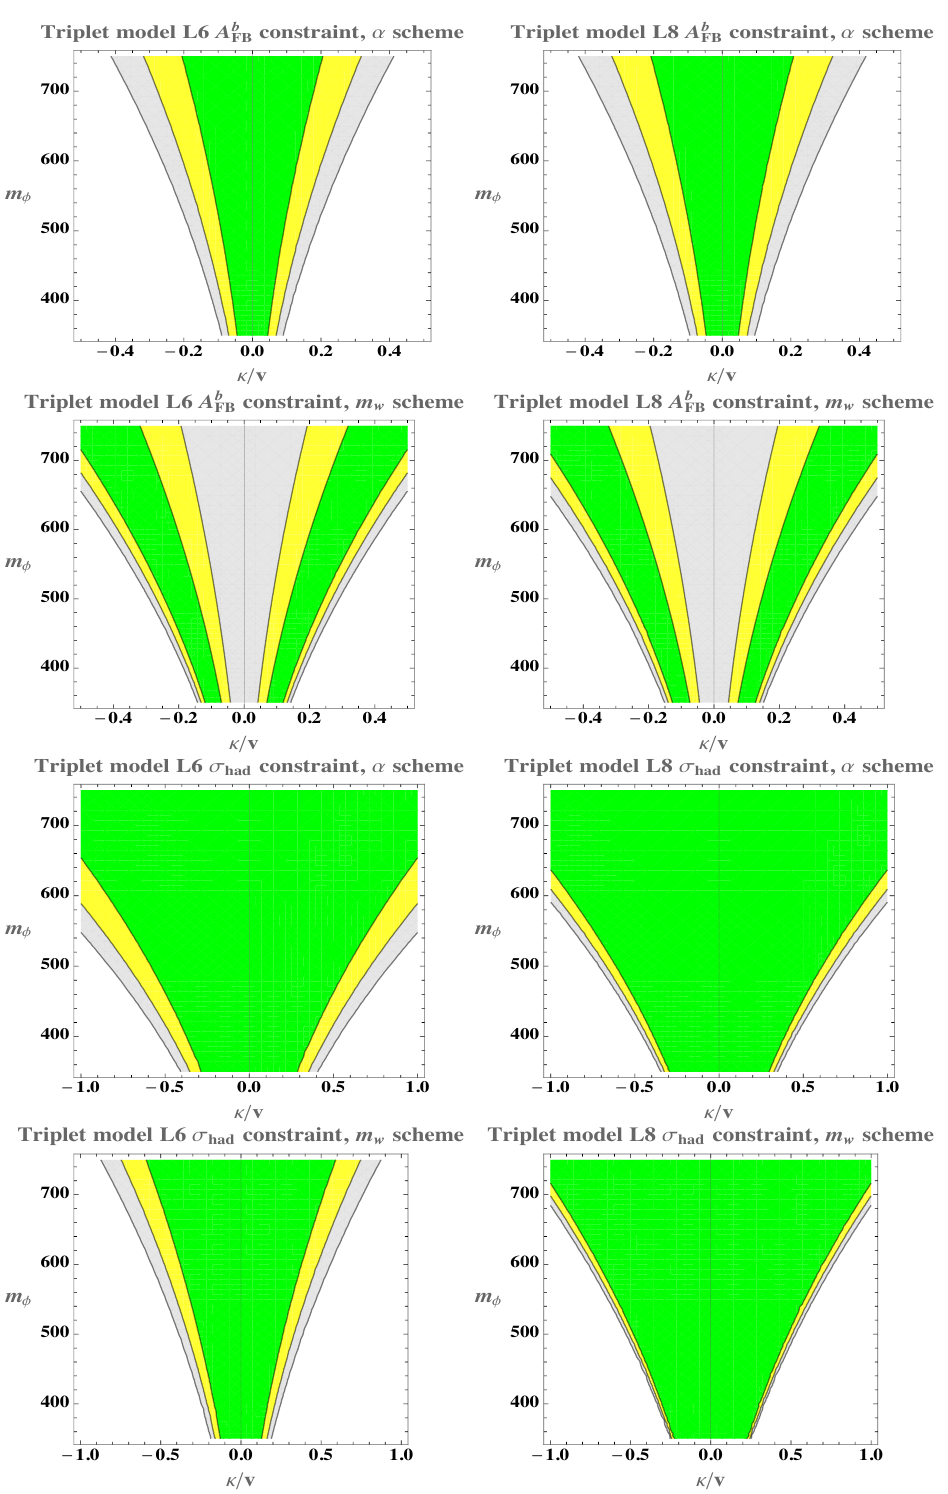
Figure 12 . Shown are the constraints on the model space from the A b